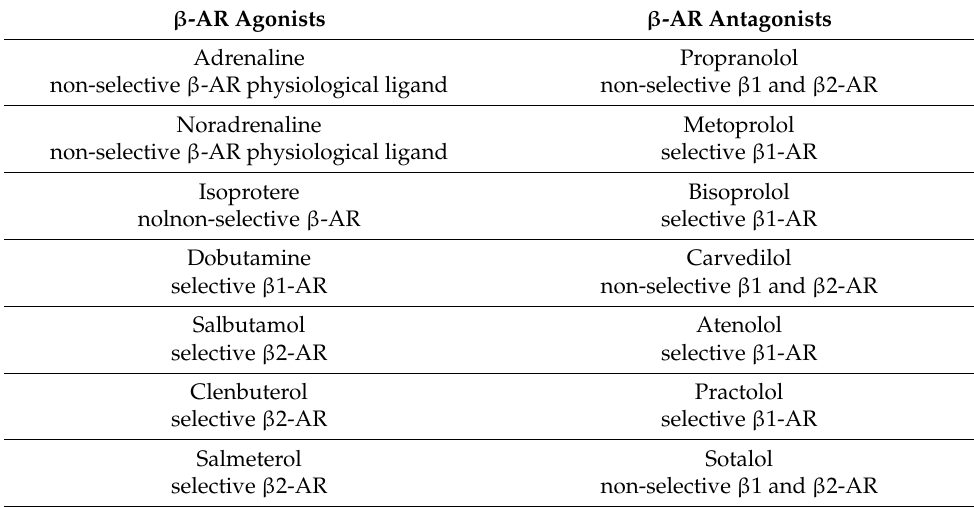
Table 1. List of selected β -adrenergic receptor agonists and antagonists. β -AR